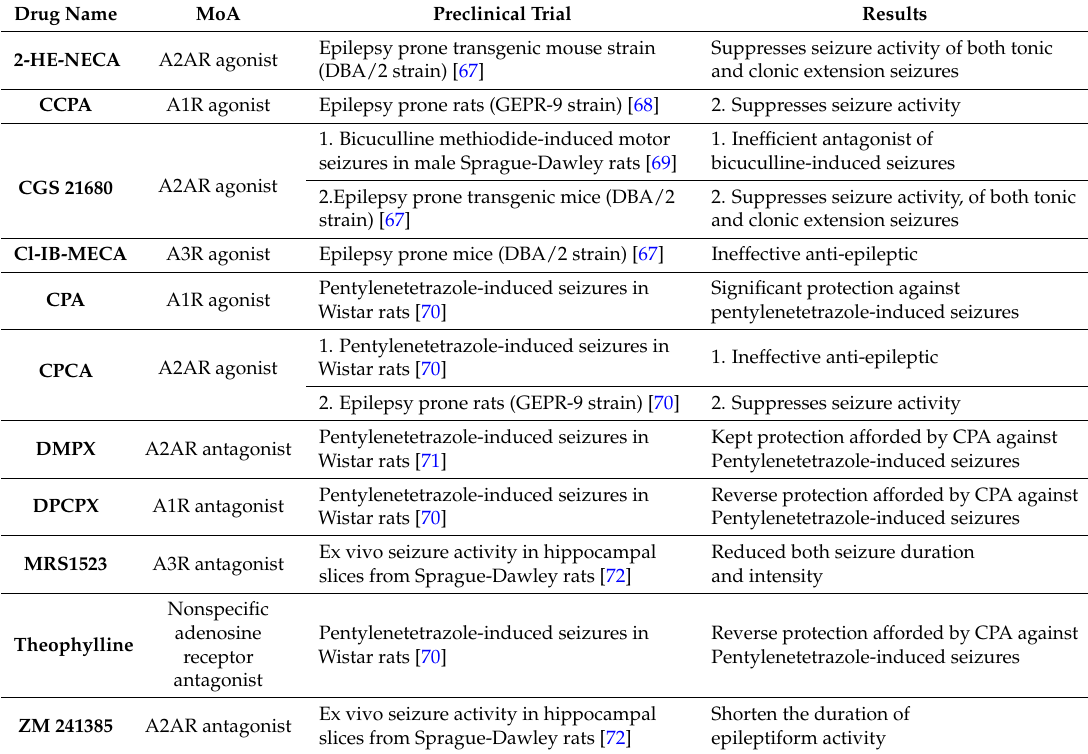
Table 1. Name, mechanism of action (MoA), use in preclinical trials and potential role of Adenosine A1, A2A, and A3 receptor agonists and